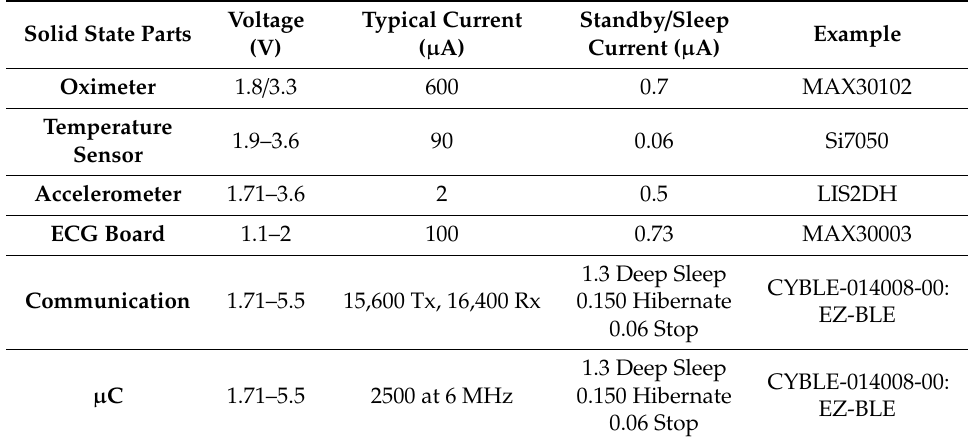
Table 4. Energy consumption for typical solid-state parts of the